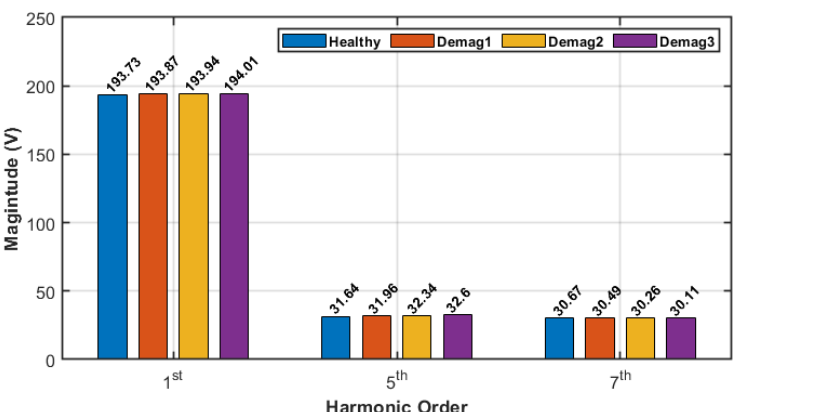
Figure 13. Variations in the harmonic content of stator voltage spectrum for healthy and faulty machine under demagnetization fault in FOC drive.